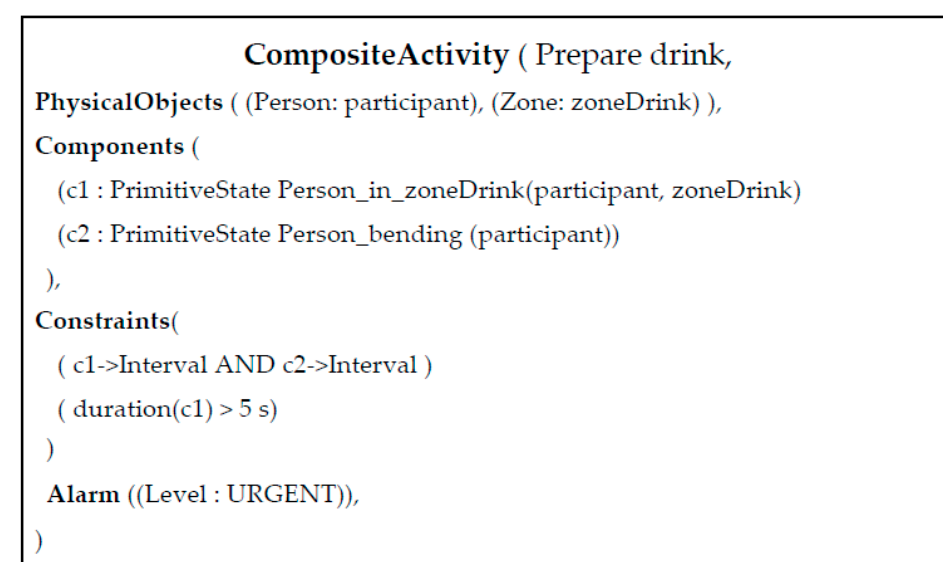
Figure 5. Composite activity model for the “Prepare drink” activity.